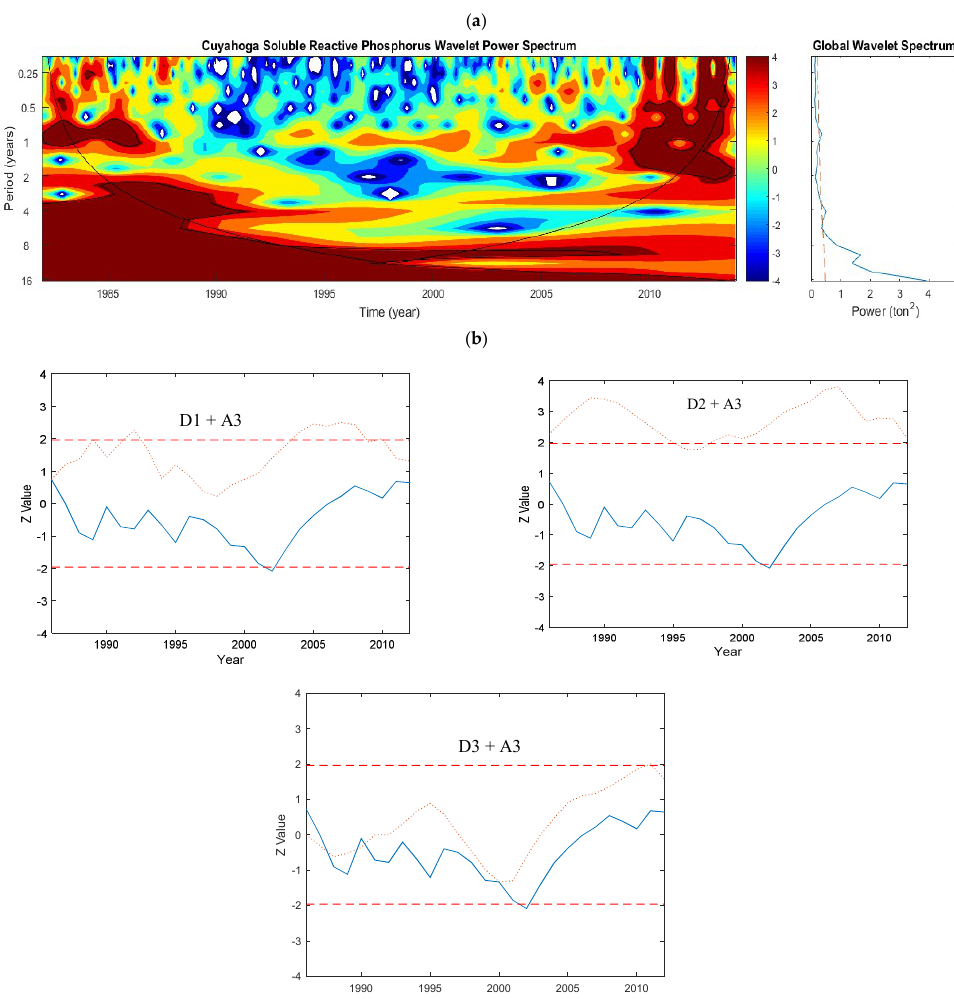
Figure 15. Cuyahoga River: ( a ) Continuous wavelet spectrum of daily streamflow. ( b ) Plots of the sequential Mann–Kendall analyses on the Details (with added Approximation component) of the annual streamflow data. The top and bottom dashed lines are ±1.96, which are the confidence limits of the MK test using α = 5%. The solid and dotted lines show the sequential MK values for the original data and the Detail components, respectively. For this streamflow data, the D3 (8 years) component was the most dominant periodicity for this trend.